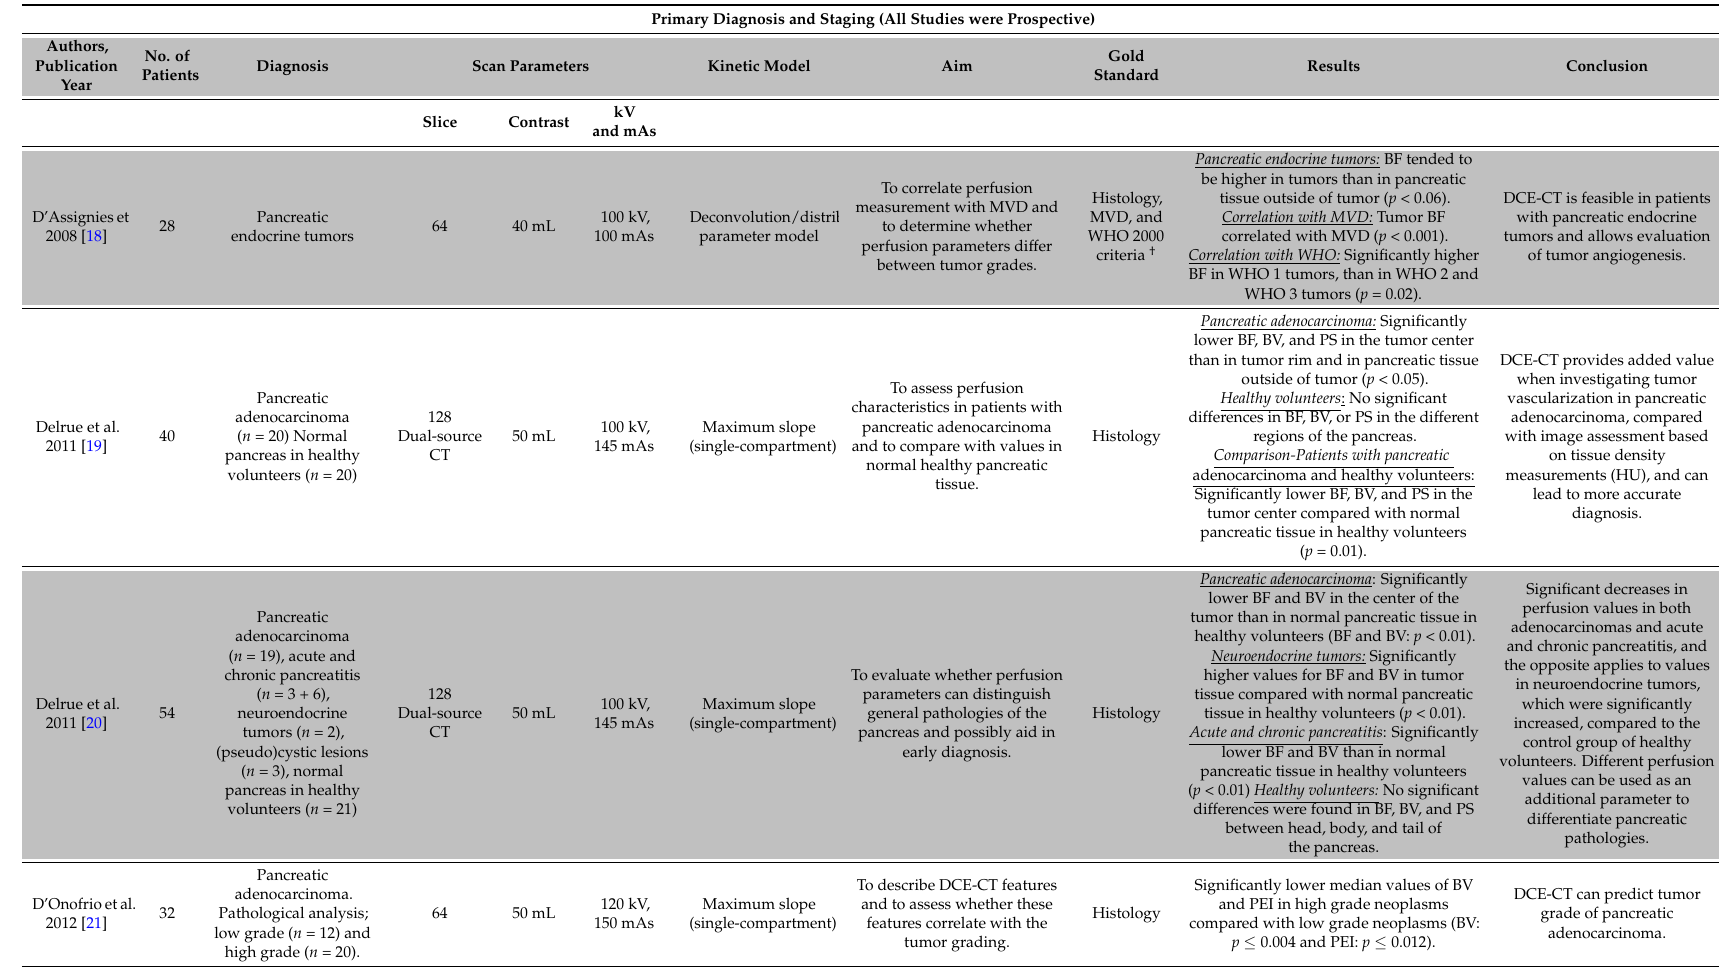
Table A1. Overview of included studies: Primary diagnosis and staging